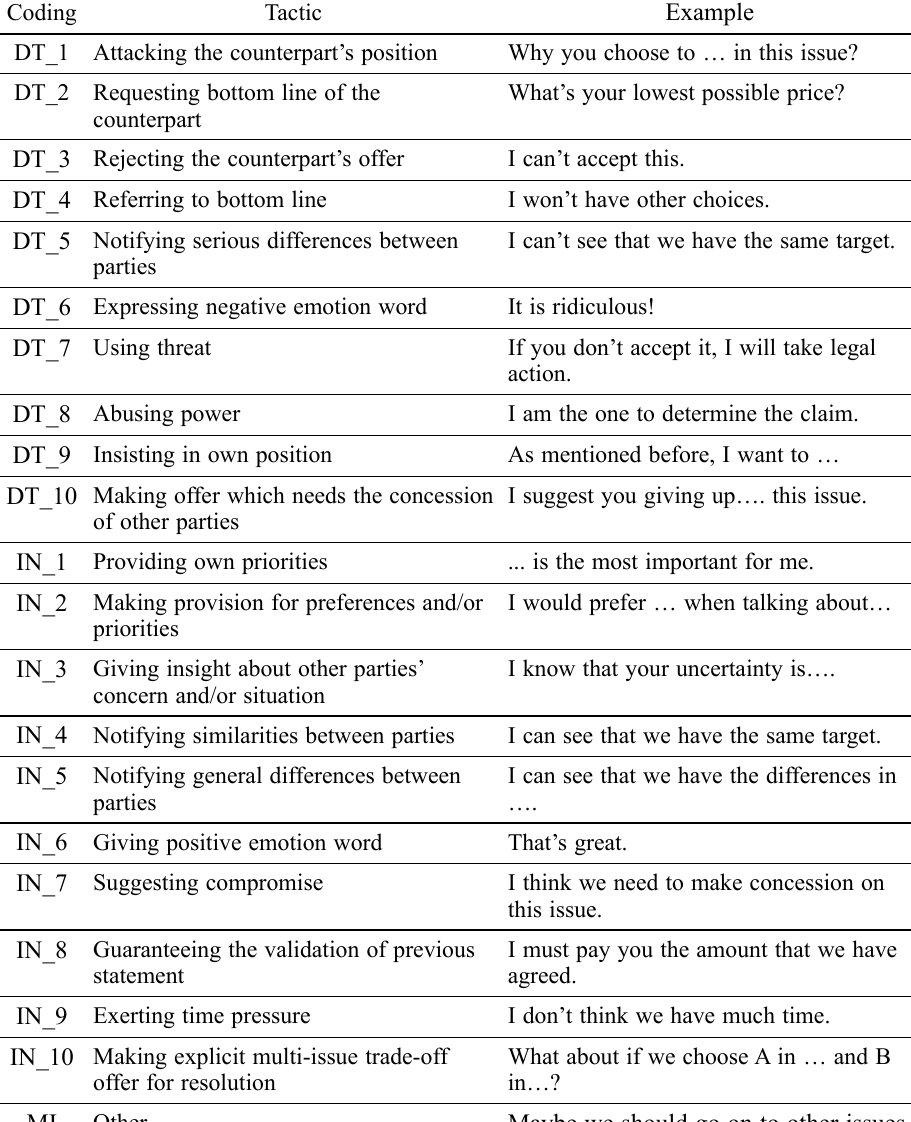
Table 1. The coding of distributive and integrative tactics Coding Tactic